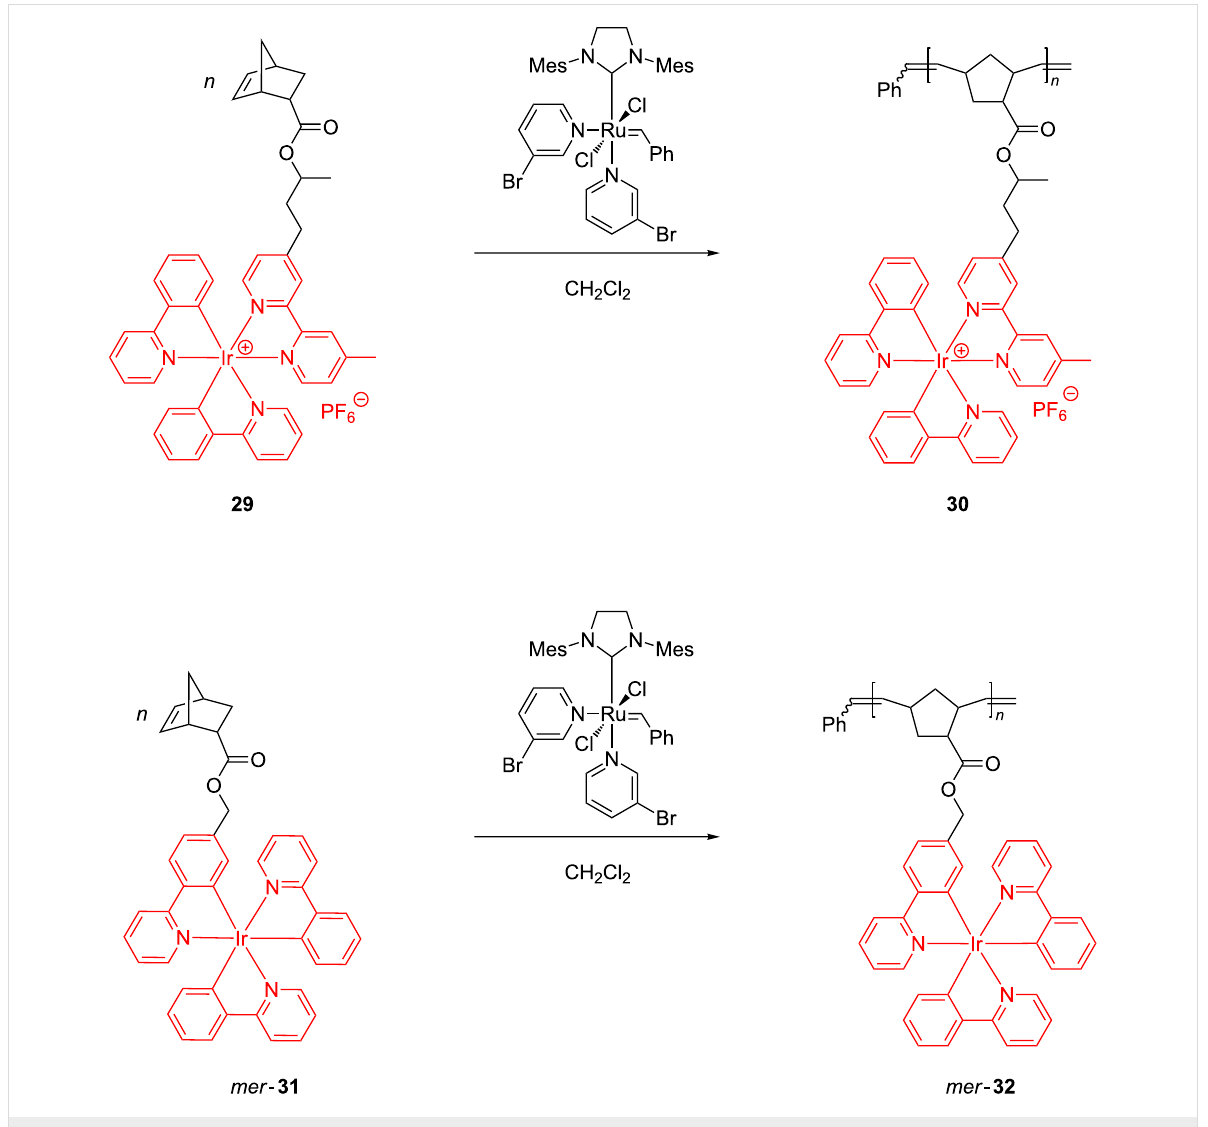
Scheme 13: Synthesis of Ir-containing homopolymers by